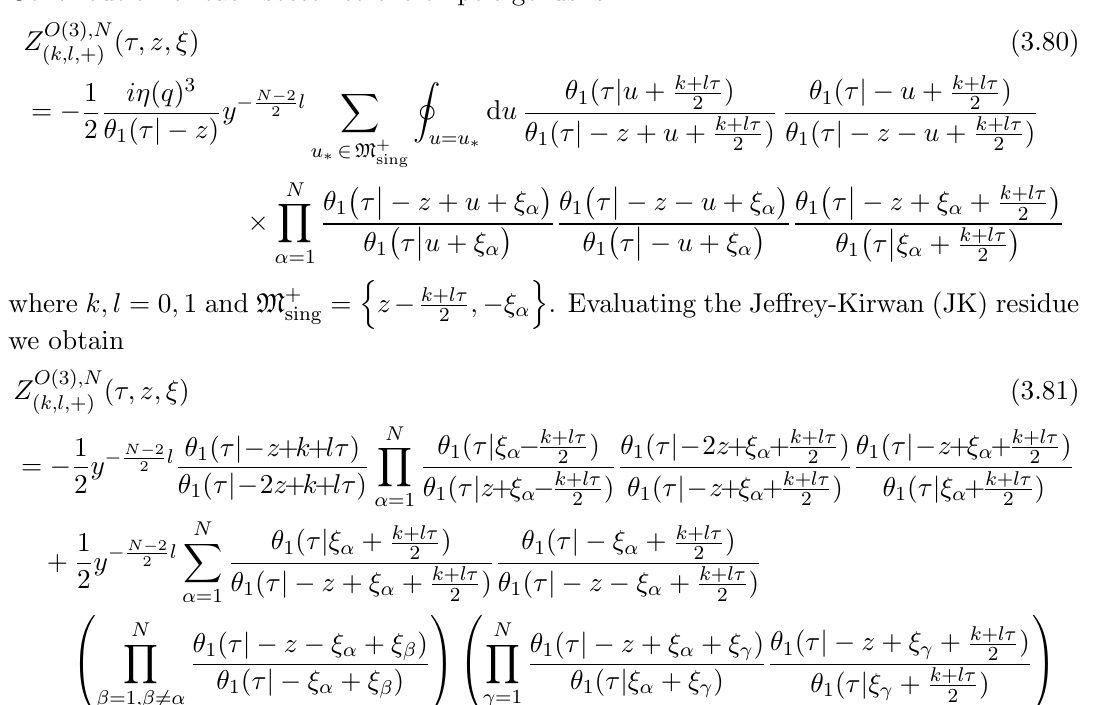
Table 4 . The total number of ground states of the O (cid:6) (3) theories. The standard Z 2 orbifold has twice as many vacua as the non-standard one. For even N , O + (3) is the standard Z 2 orbifold while O (cid:0) (3) is the non-standard Z 2 ( (cid:0) 1) F s orbifold. For odd N, the role of O + (3) and O (cid:0) (3) are reversed. Contribution of each sector to the elliptic genus